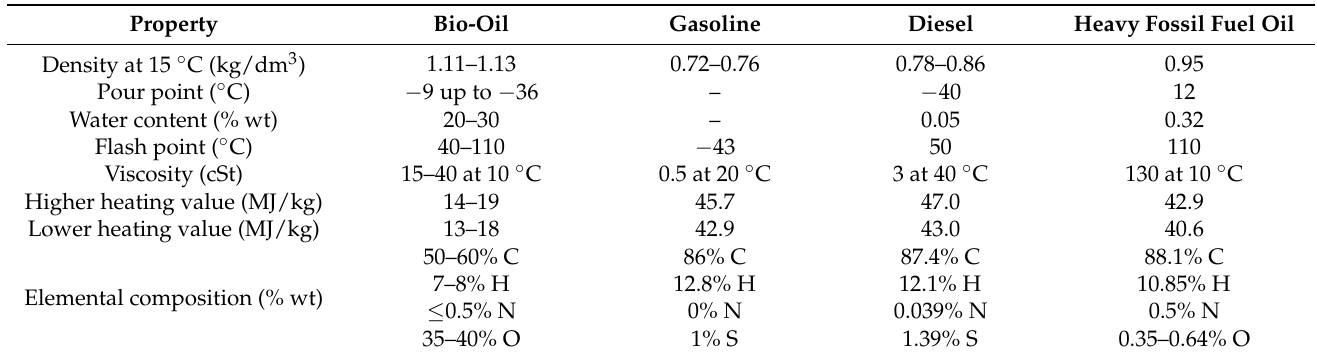
Table 2. Typical fuel properties of bio-oil and fossil fuels